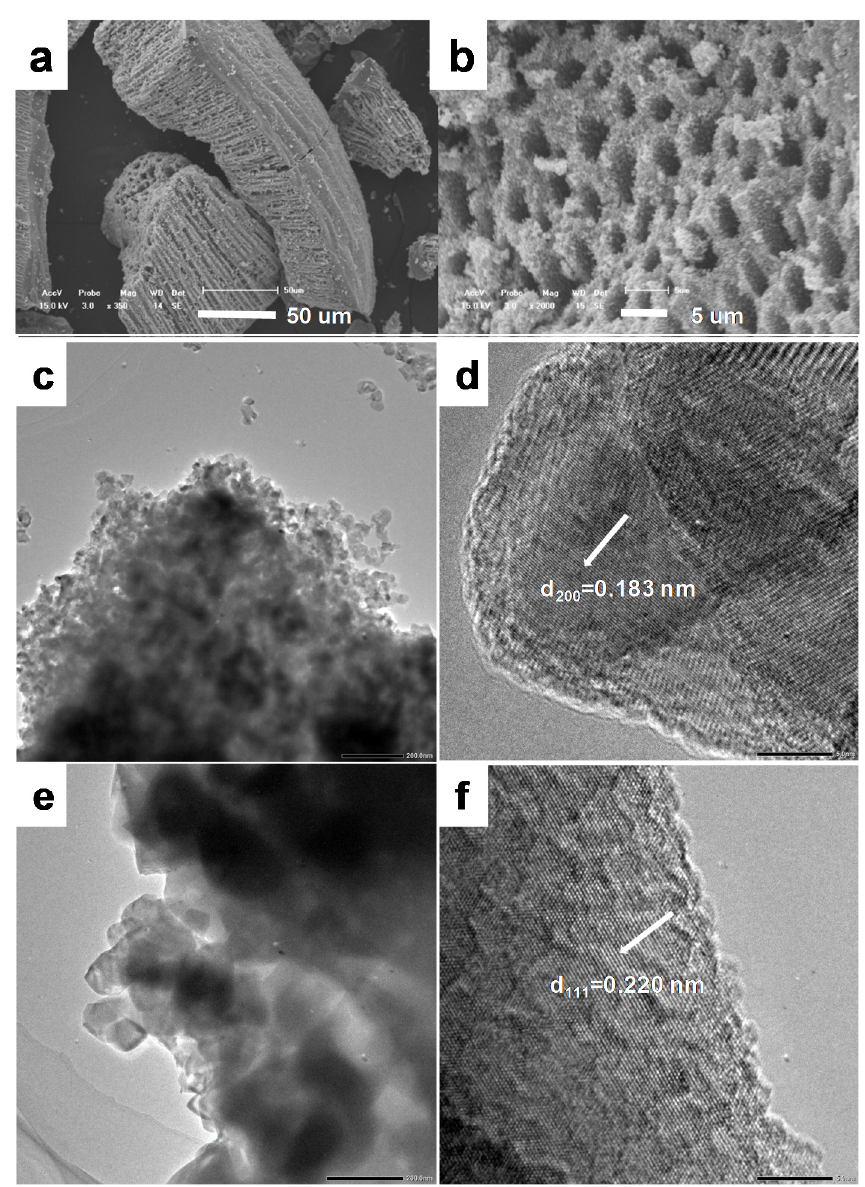
Figure 3. ( a , b ) SEM images of titanium oxide obtained by thermal decomposition at 800 °C TiO 2 -800. ( c , d ) TEM imaged of TiO 2 -550. ( e , f ) TEM imaged of TiO 2 -800.